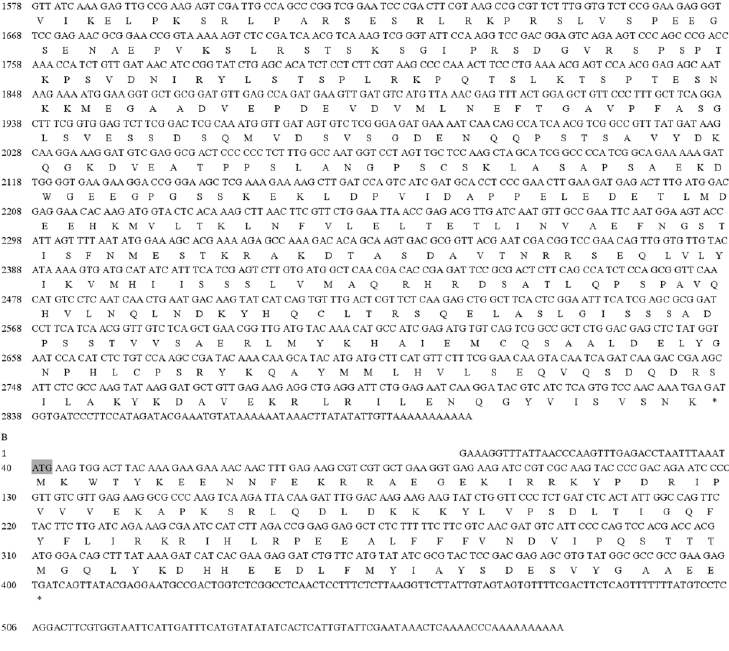
( A ), including the oesophageal gland cells (right arrows), and lateral hypodermal seam cells (left arrows). Control sense probe in B. xylophilus ( B ). The scale bars = 100 µm.